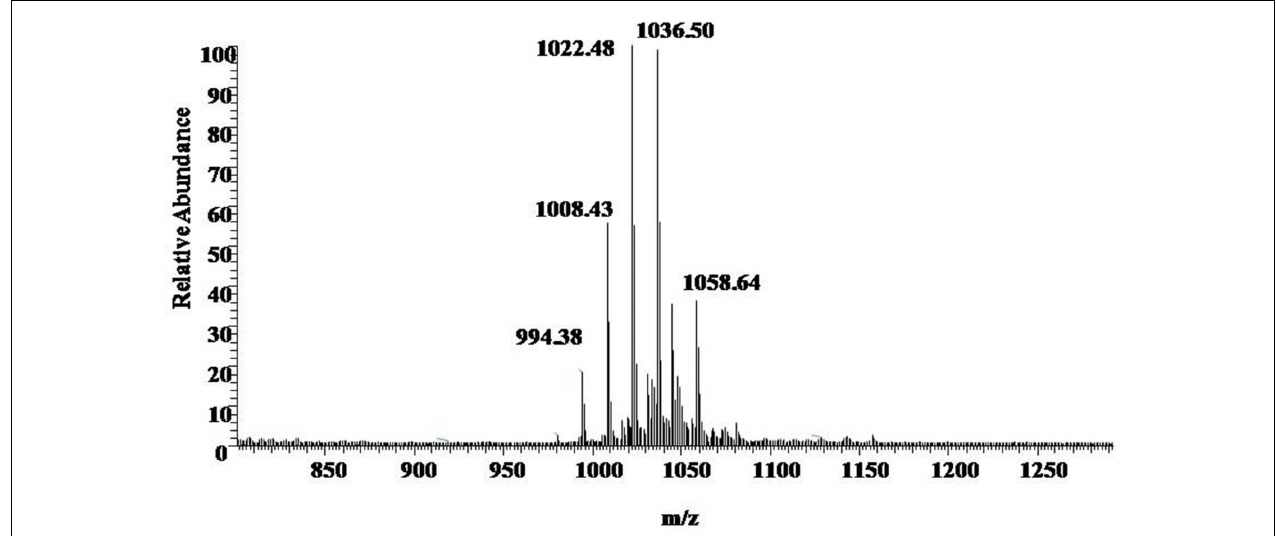
FIGURE 3 | ESI Full MS of Sample. [M + H] + m/z 994, 1008, 1022, and 1036 are the characteristics of the molecular weight of surfactin.